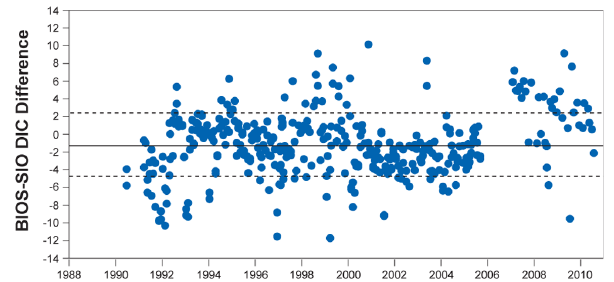
Fig. 2. Comparison of DIC analysed at BIOS and SIO. Differences shown in µmolkg − 1